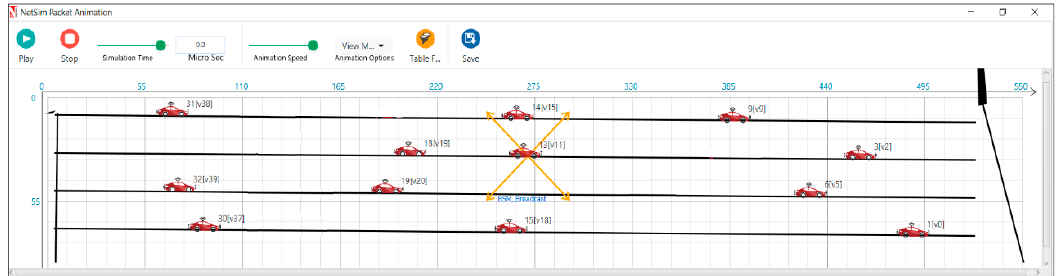
Figure 7. Clustering of vehicles in an average traffic scenario.